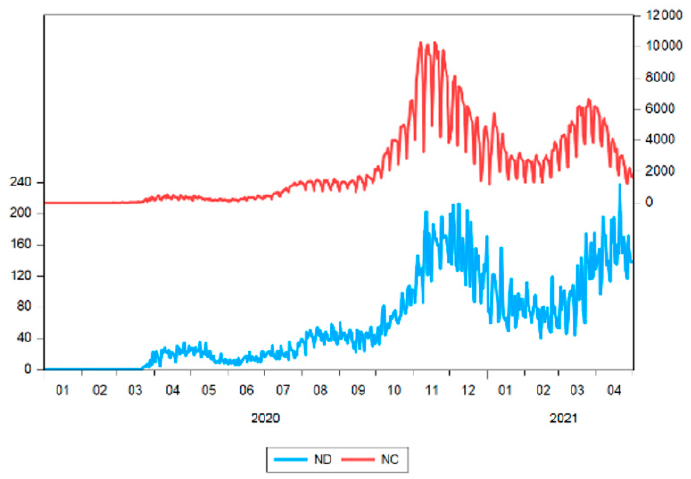
Figure 4. Evolution of COVID-19 pandemic in terms of the number of new deaths (ND) and number of new cases (NC). Source: authors’ contribution using EViews 10 software.